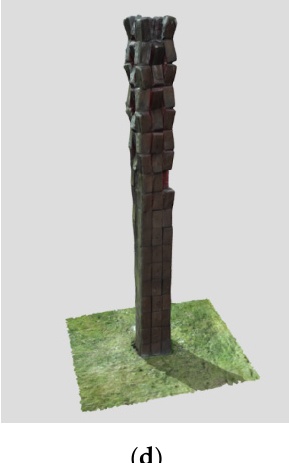
Figure 2. Different stages of representation. ( a ) Tower of Babel (Jon Oxman, 1978); ( b ) texture and photogrammetric 3D presentation in MeshRoom (Authors of 3D presentation: Luka Obal, Alja Berlot); ( c ) texture and photogrammetric 3D presentation in Agisoft Metashape (authors of 3D presentation Urška Klenovšek, Karmen Kogej, Hana Ocvirk, Mylana Peresypkina); ( d ) representation of sculpture on